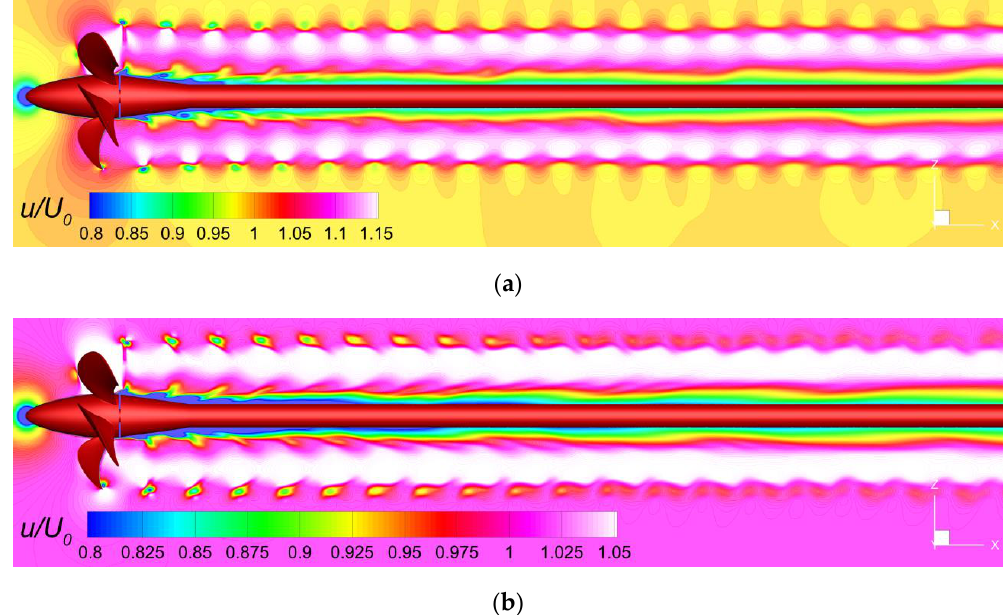
Figure 9. Non-dimensional axial velocity field computed in the domain longitudinal plane of symmetry. ( a ): 𝐽 = 0.6418 ; ( b ): 𝐽 = 1.602 .